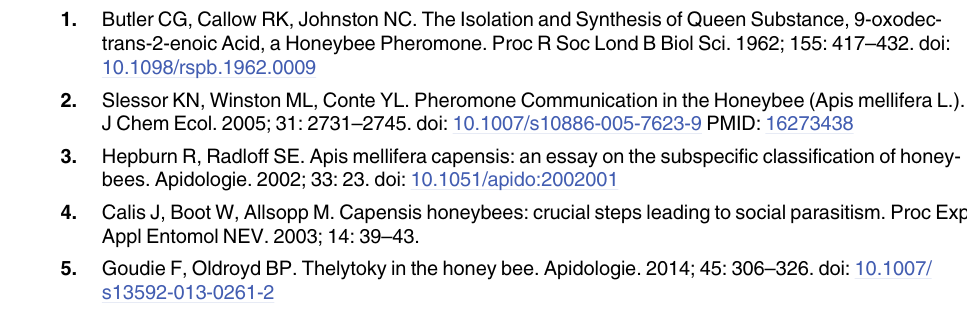
S1 Table. Fixed SNPs between Cape bees and the African background population. S2 Table. Top 1000 SNPs ranked for the Composite Selection Score (CSS) between Cape bees and the African background population. S3 Table. Information about the 97 accessions associated with the top 1000 CSS SNPs. S4 Table. Significantly enriched Gene Ontology terms detected among the Drosophilia orthologs of the candidate